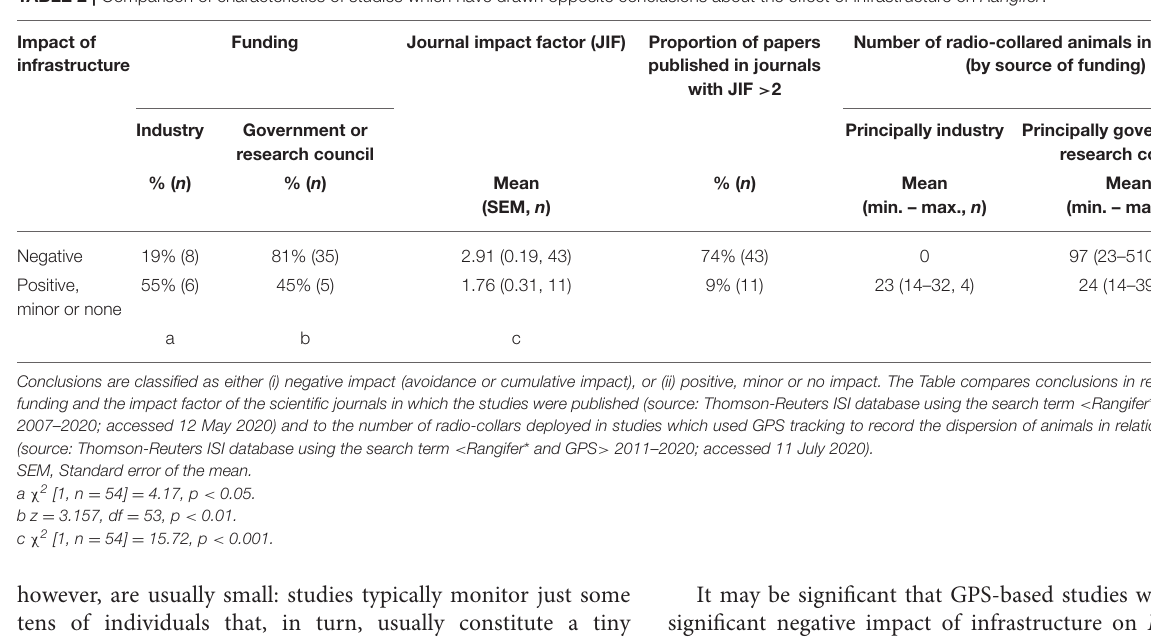
TABLE 2 | Comparison of characteristics of studies which have drawn opposite conclusions about the effect of infrastructure on Rangifer